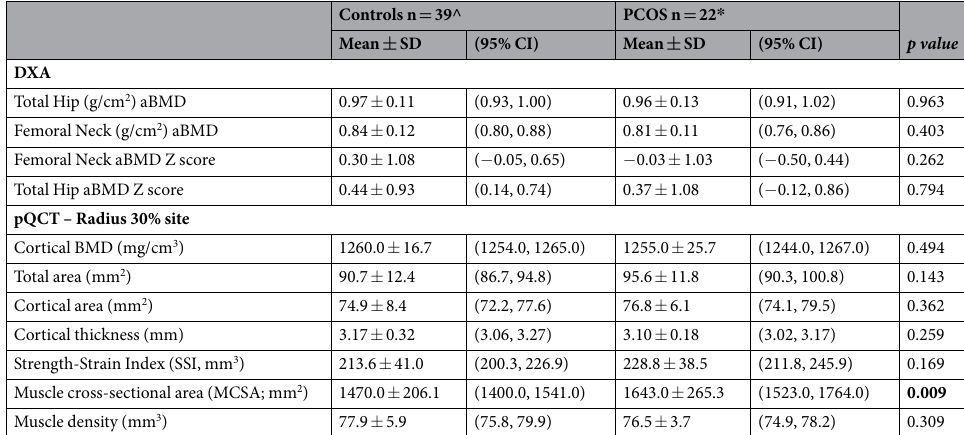
Table 2. Bone and muscle parameters of premenopausal women with polycystic ovary syndrome (PCOS) and controls. ^4 women failed the muscle analysis due to movement artifacts. * 1 woman was over the weight limit for the DXA hip scan (n = 21); 1 woman failed the muscle analysis due to movement artifact (n = 21).